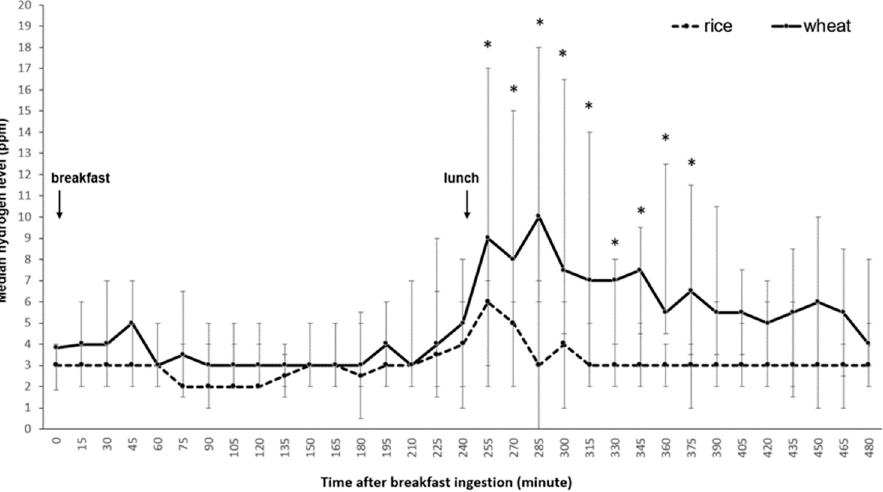
Figure 3. Exhaled hydrogen gas concentrations after ingestion of different test meals. * p < 0.05 wheat noodles vs. rice noodles.